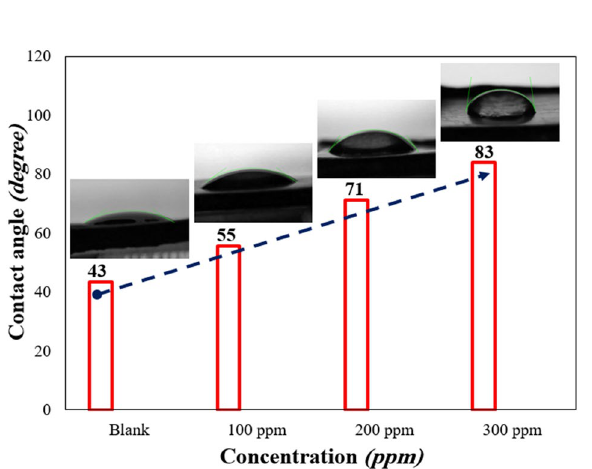
Figure 11. Water droplet contact angle for MS subjected to different concentrations of GSE solutions.